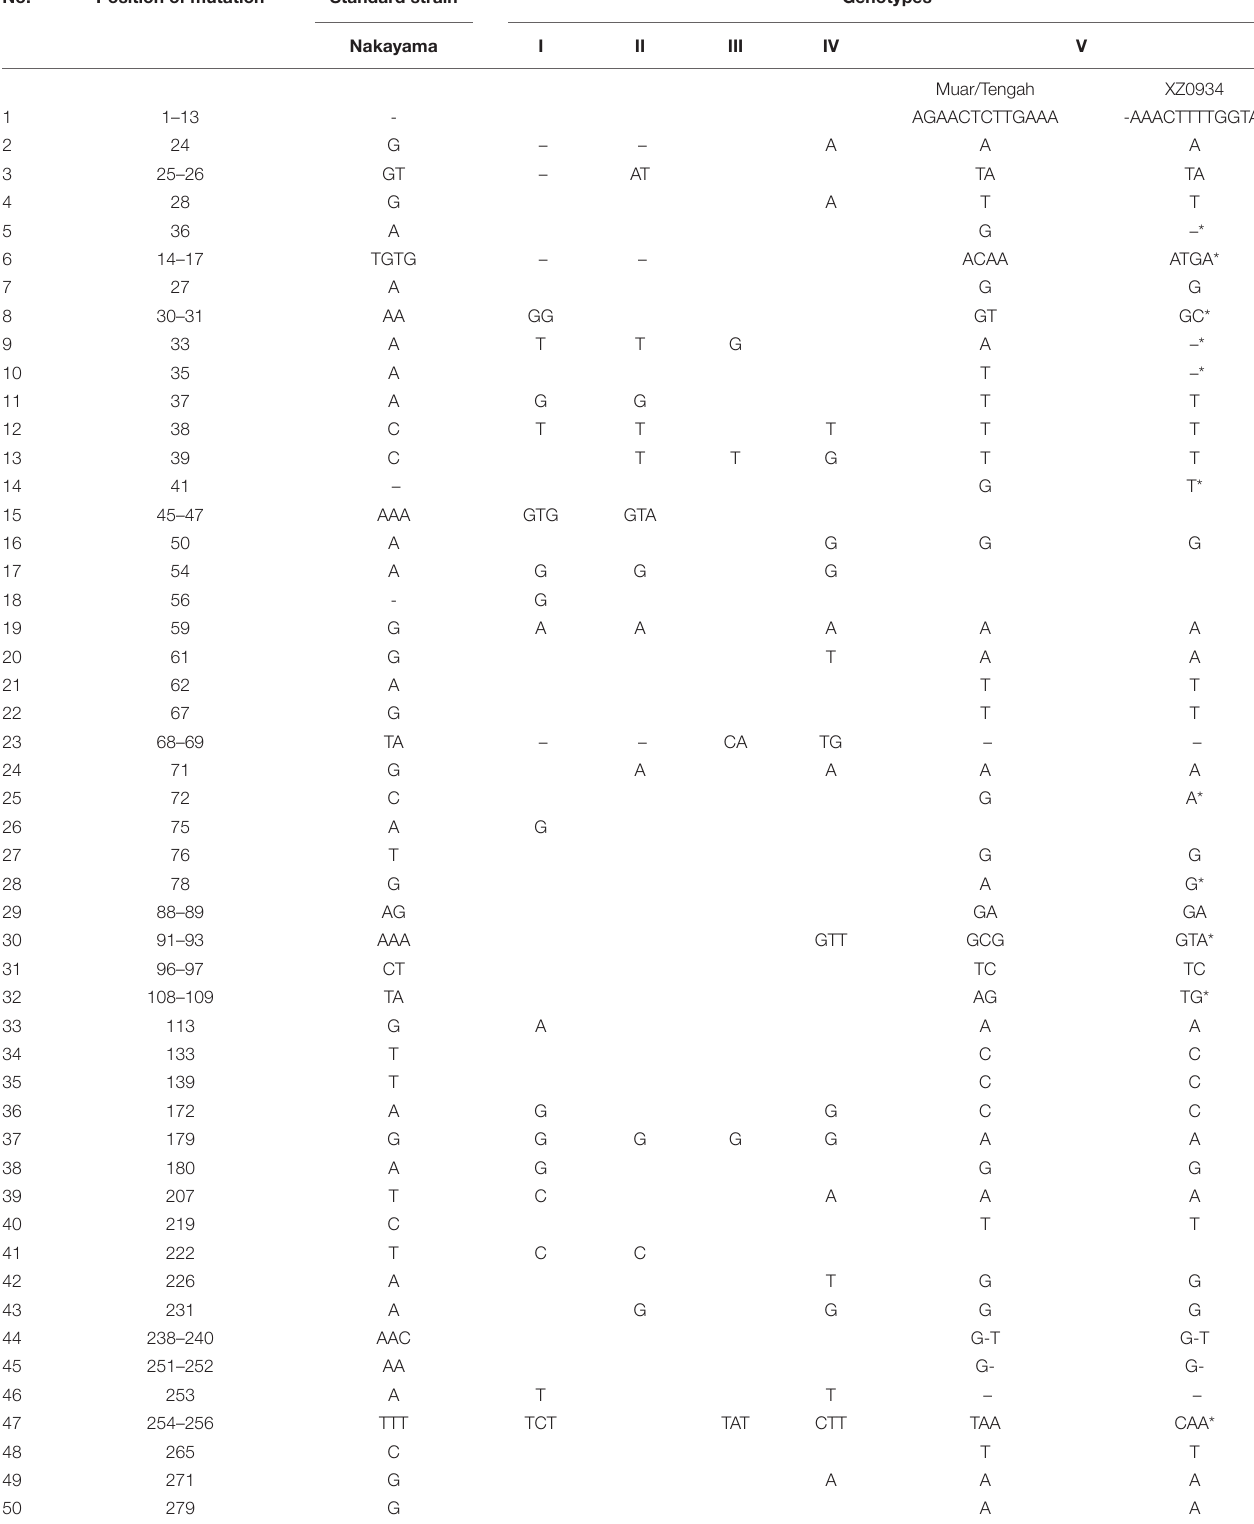
TABLE 3 | The nucleotide differences within the 3 (cid:48) UTRs between JEV genotypes. No. Position of